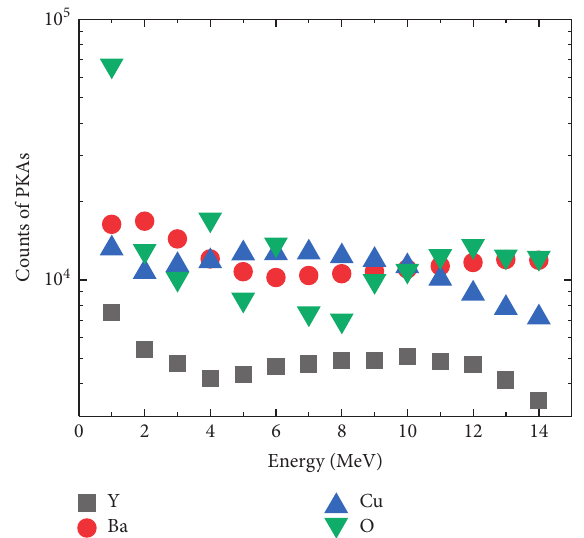
Figure 5: The counts of PKAs generated by neutrons with different energies.